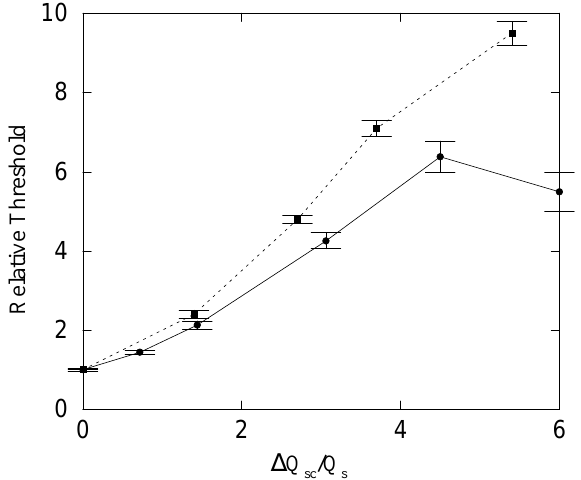
FIG. 9. Threshold wake in units of the threshold wake for D (cid:81) (cid:115)(cid:99) (cid:173) (cid:48) vs D (cid:81) (cid:115)(cid:99) (cid:121) (cid:81) (cid:115) for different line densities: m (cid:173) (cid:49) , circles, solid line; m (cid:173) 2 (cid:49) (cid:121) (cid:50) , squares, short dashed